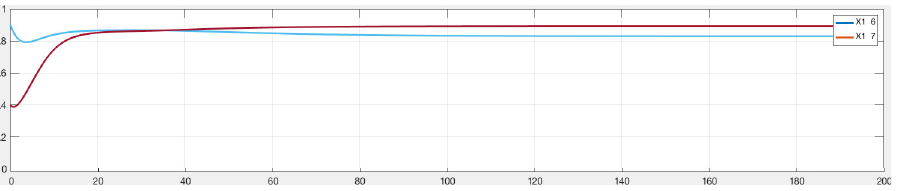
Fig. 5. Simulation results for suppression and Hebbian learning for ! 1 (connection X 1 – X 6 ) and ! 2 (connection X 1 – X 6 ) (Scenario